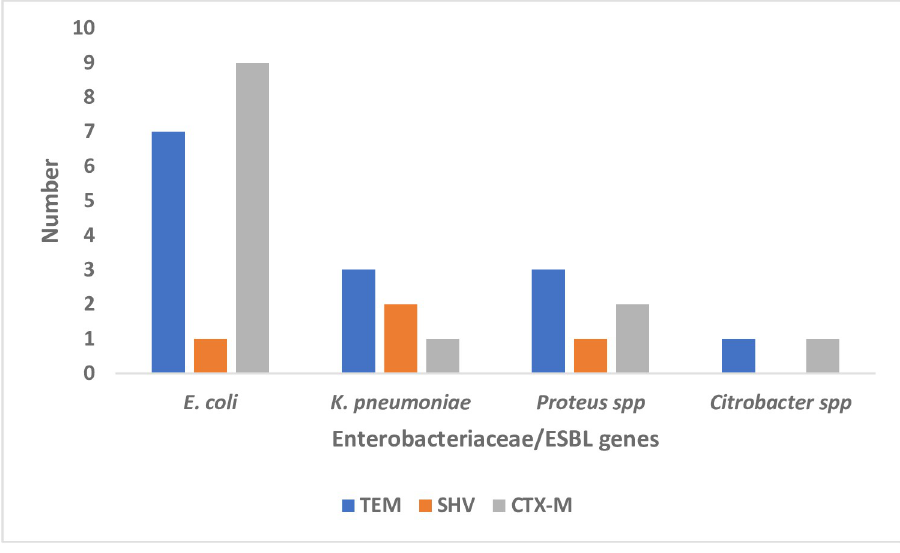
Fig 3. Specific ESBL genes tested among the various Enterobacteriaceae isolates. This shows the presence/ absence , bla and bla genes from phenotypically positive isolates among the E . coli , K . pneumoniae and of bla CTX-M SHV TEM Proteus mirabilis , and Citrobacter freundii isolates recovered in the stool